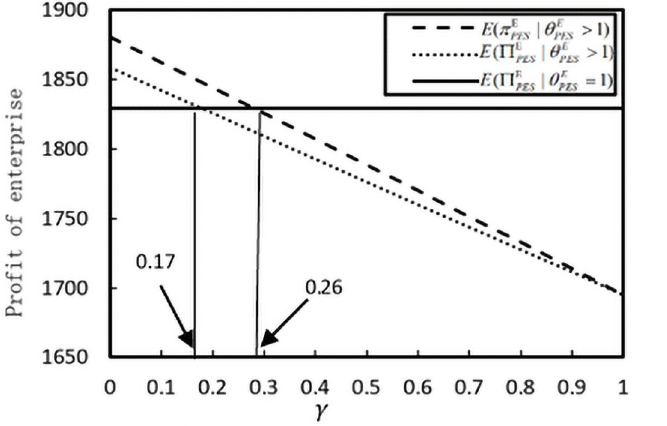
Fig 5. The impact of γ on the profit of enterprise.